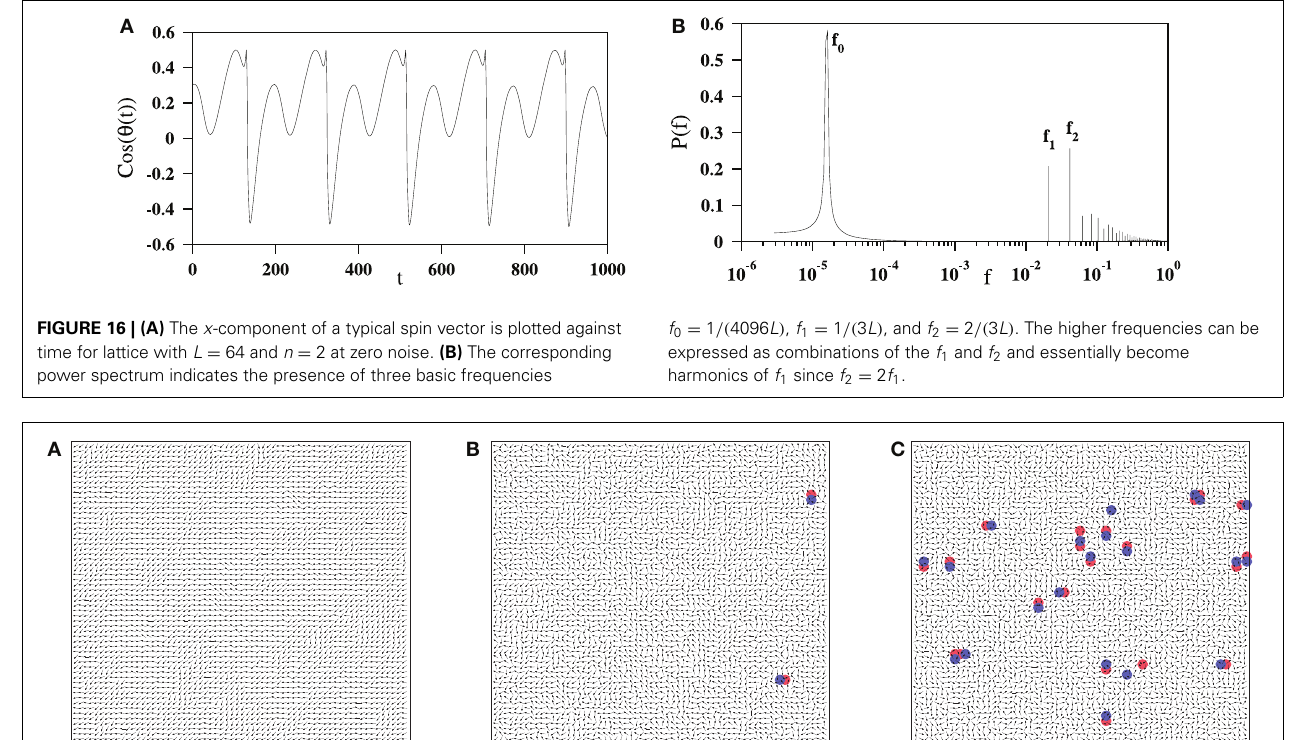
two vortex-antivortex pairs, and (C) for η = 0 . 40 twenty one vortex-antivortex pairs can be seen. Filled circles of two different colors, red for vortices and blue for antivortices, have been drawn around the vortex centers.